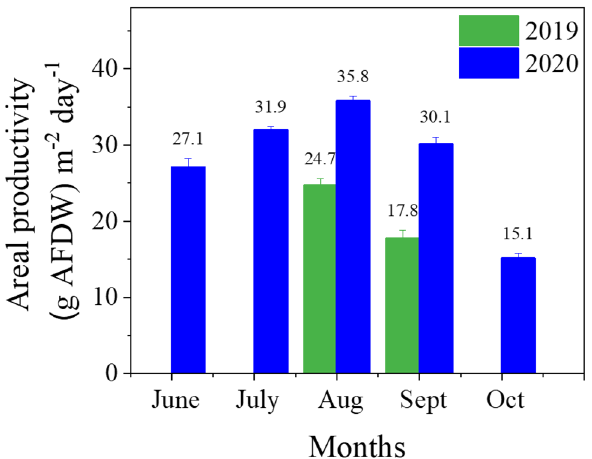
Figure 2. Monthly productivity: Average areal biomass productivity calculated on a monthly basis. For the three ponds, for each month, an average daily productivity was obtained. Data represent the averages and standard deviations of this monthly average from the three